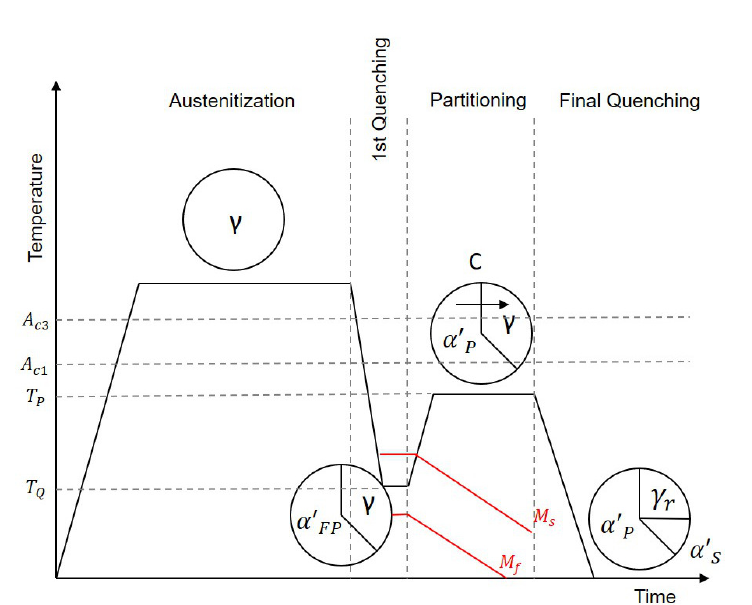
Figure 1. Schematic description of the Q&P process and the microstructural evolution during the heat